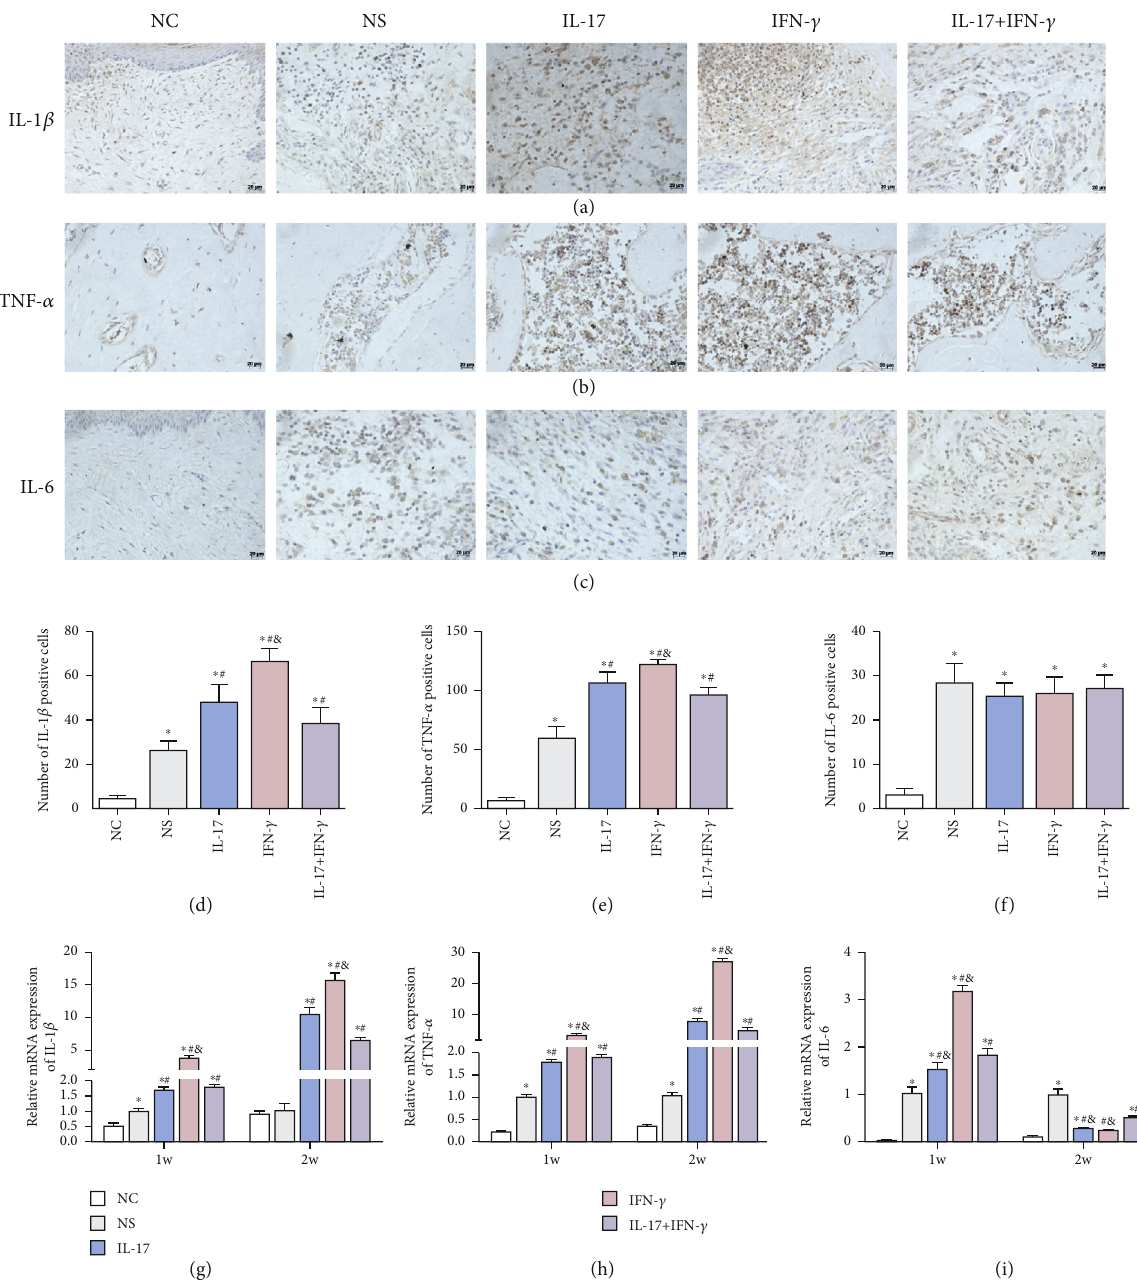
Figure 4: E ff ect of IL-17 (5 μ g/ml) or/and IFN- γ (1 μ g/ml) on proin fl ammatory cytokine expression in vivo . Immunohistochemical staining was used to examine the level of (a) IL-1 β , (b) TNF- α , and (c) IL-6 expression in gingival tissues ( scale bar = 20 μ m ). Quantitative analysis results of (d) IL-1 β -, (e) TNF- α -, and (f) IL-6-positive cells are shown. The mRNA level of (g) IL-1 β , (h) TNF- α , and (i) IL-6 in gingival tissues after 1 week and 2 weeks was detected by RT-qPCR. Data were presented by mean ± standarddeviation , n = 5 . ∗ p < 0 : 05 compared with the NC group, # p < 0 : 05 compared with the NS group, and & p < 0 : 05 compared with the IL-17+IFN- γ